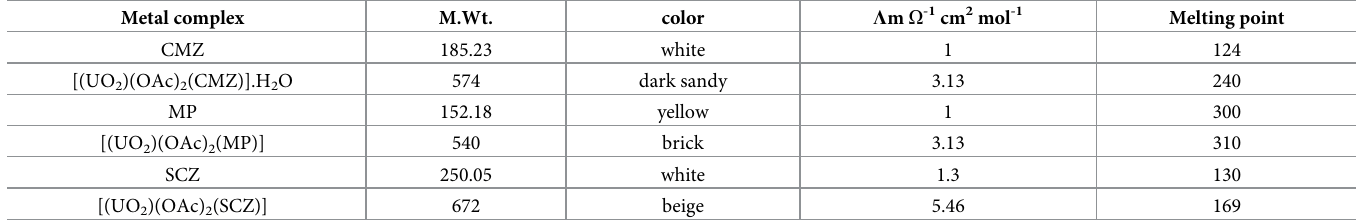
Table 1. Physical and analytical data of the free ligand and the uranyl complexes. Metal complex M.Wt.